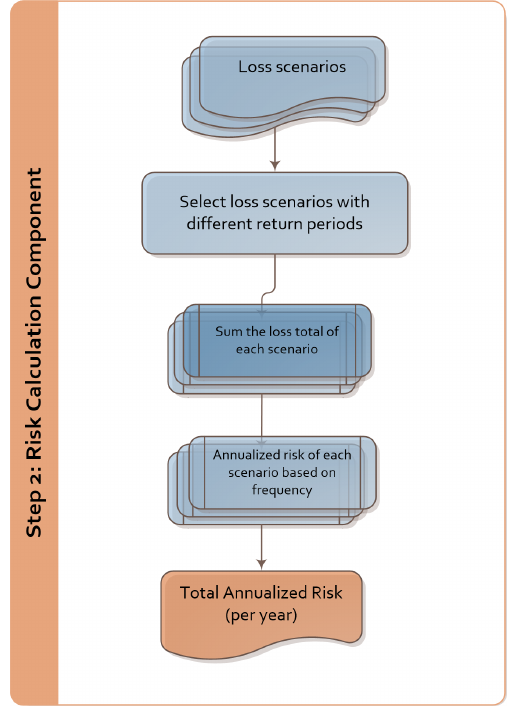
Figure 6. Workflow of the risk calculation component. The loss sce- narios with different return periods are combined to obtain the total annualized risk (per year) based on the staircase